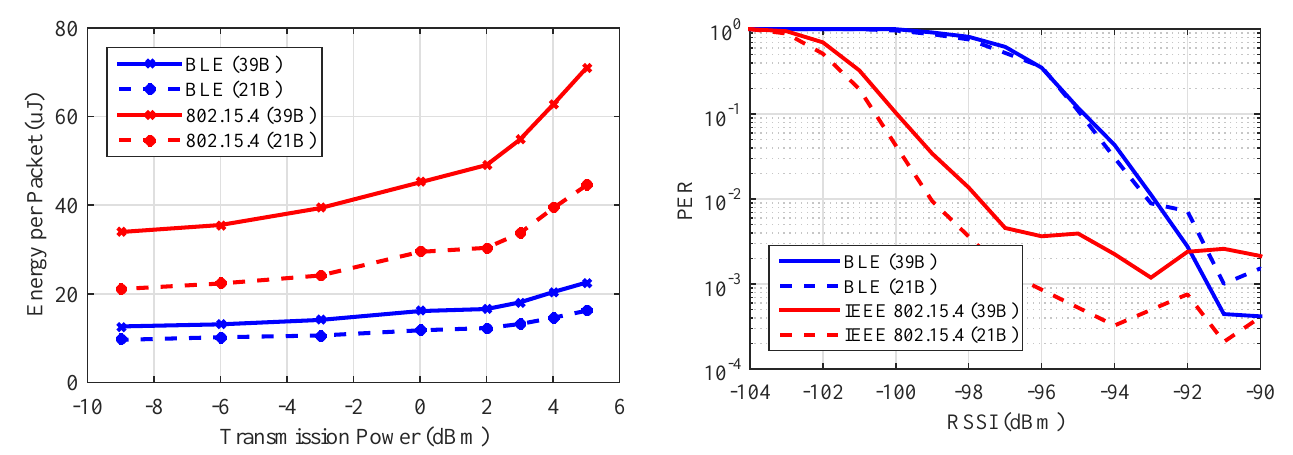
Figure 1. Energy consumption of a single frame transmission for two PHY payload sizes, and for various transmission power levels.